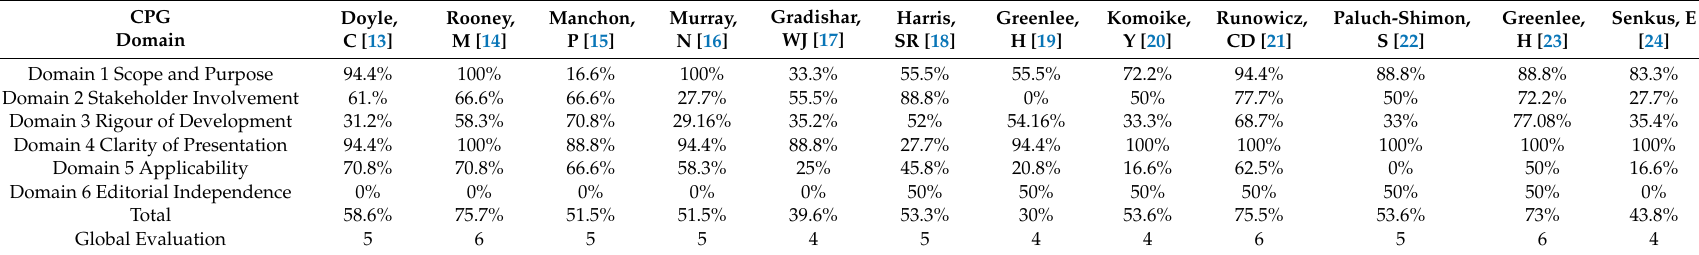
Table 3. Results of the evaluation of the clinical practice guidelines selected for the present study evaluated with the Appraisal of Guidelines for Research and Evaluation (AGREE II)